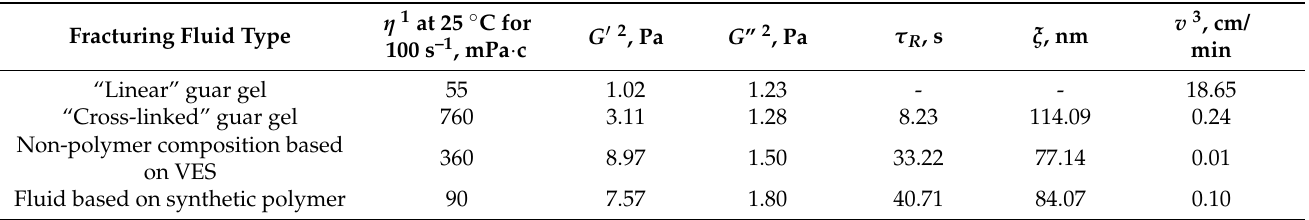
Table 1. Comparative analysis of the structural and mechanical properties of various types of fracturing